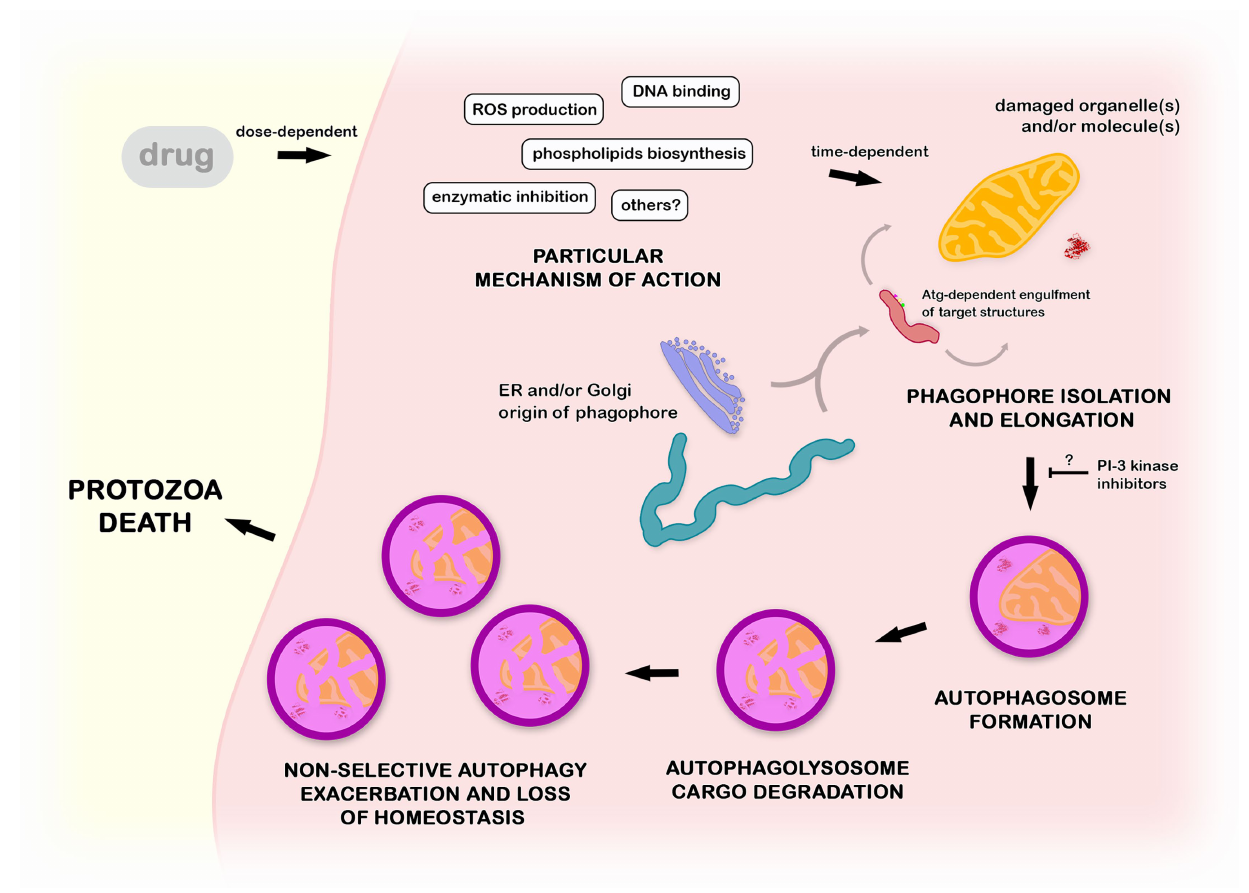
FIGURE 7 | Mechanistic proposal of autophagy in the mode of action of anti-protozoa drugs. Compounds with distinct mechanisms of action lead to the impairment of cellular structures such as organelles and macromolecules. Such damaged structures are randomly engulfed by a phagophore in a Atg-dependent process, forming an autophagosome. After the fusion with lysosome, the cargo is degraded inside the autophagolysosome. The non-selective continuous autophagic exacerbation promotes the breakage of the protozoa homeostasis, culminating in an accumulation of a high number of autophagic vacuoles (autophagosomes and/or autophagolysosomes) and consequent autophagic cell death. This process could be at least partially inhibited by the pre-incubation with classical PI-3 kinase inhibitors as wortmannin or